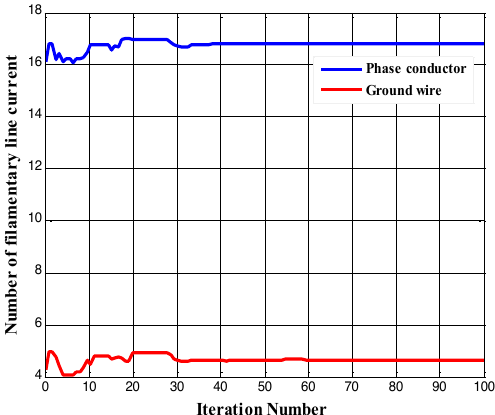
Figure 7: Convergence of the optimum values of number of filamentary line current.